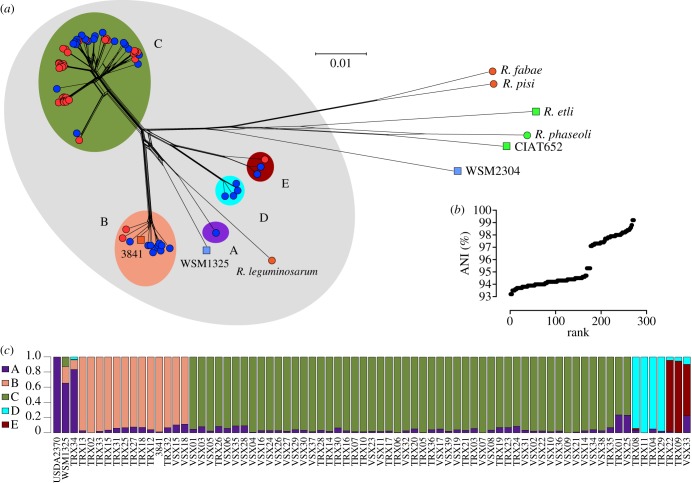
(a) NeighborNet phylogeny of the isolates and related sequenced bacteria based on 305 conserved genes. Symbol colour indicates symbiovar: red, viciae; blue, trifolii; green, phaseoli. The new isolates (unlabelled symbols) are identified in electronic supplementary material, figure S3. Named species are represented by their type strains. Round symbols indicate genome sequences obtained in this study; square symbols indicate published genome data. Background colours indicate R. leguminosarum as currently defined (grey), and the five genospecies A–E are identified within R. leguminosarum (coloured). (b) Ranked values of ANI for all pairwise comparisons of selected strains representing genospecies A–E, based on all shared homologous sequences (see electronic supplementary material, table S2). (c) Structure plot showing contribution to each strain from each of five hypothetical ancestral populations.